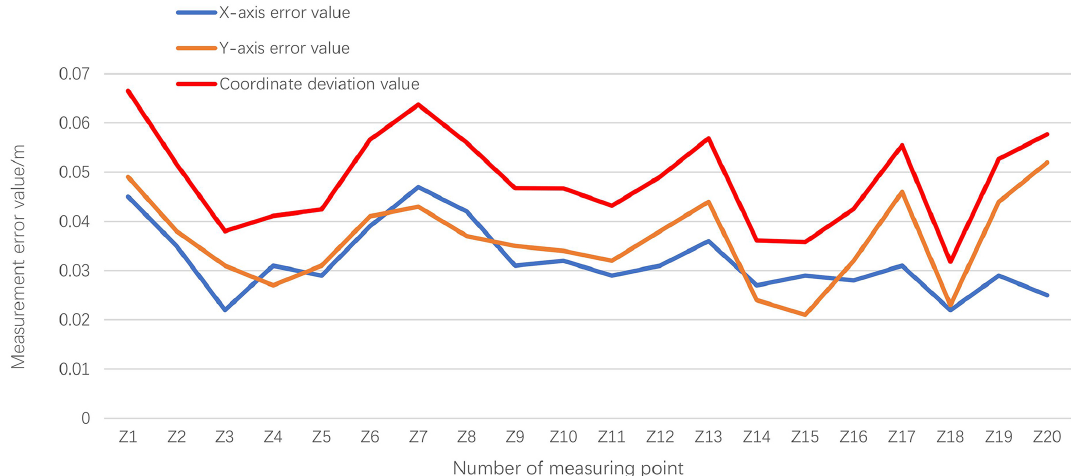
Figure 12. Error of the measurement